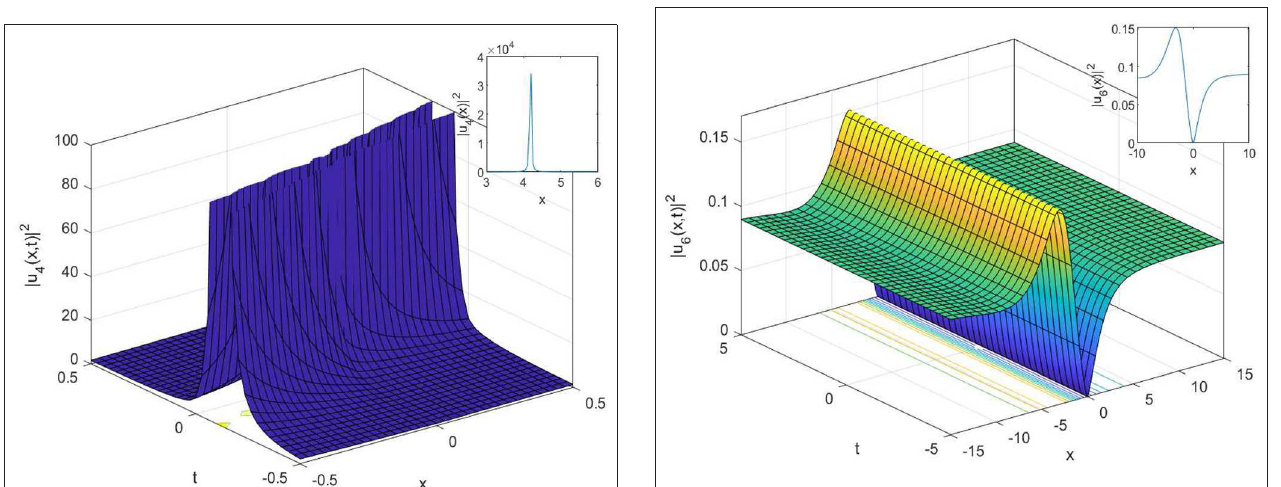
FIGURE 6 | 3D, 2D, and contour surfaces of Equation (36) where c 2 0.2, A 1 0.3, α = = =